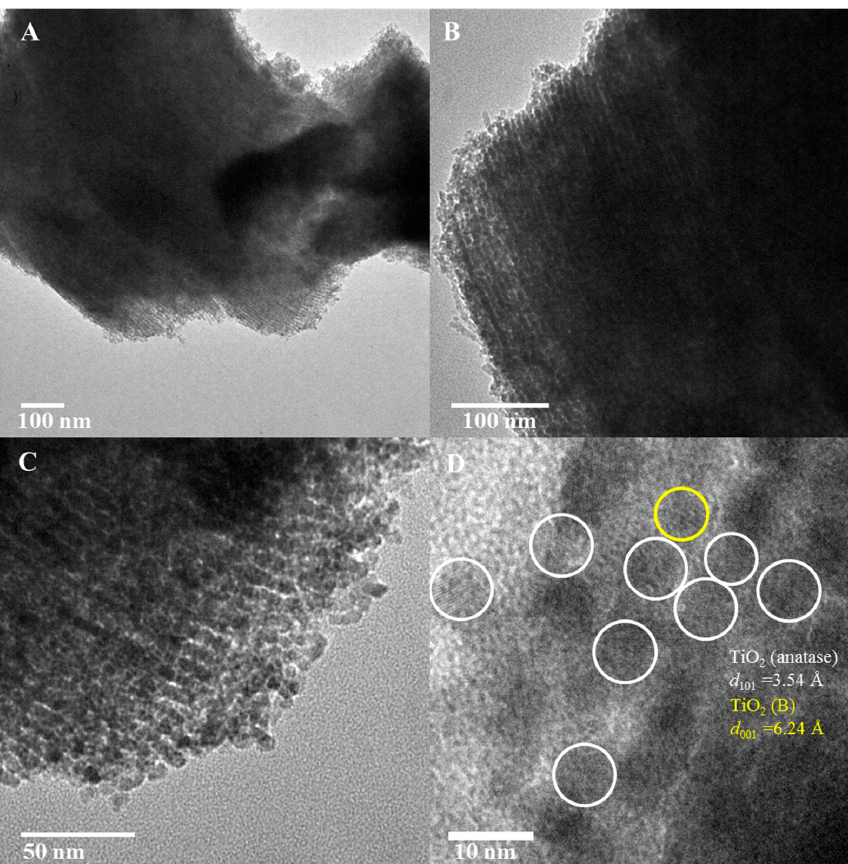
Figure 7. TEM of TiO 2 -10 (( A–C ) low magnification and ( D ) high magnification) nanocasted titania mesoporous materials. The yellow and white circles represent TiO 2 (B) and anatase phase respectively.